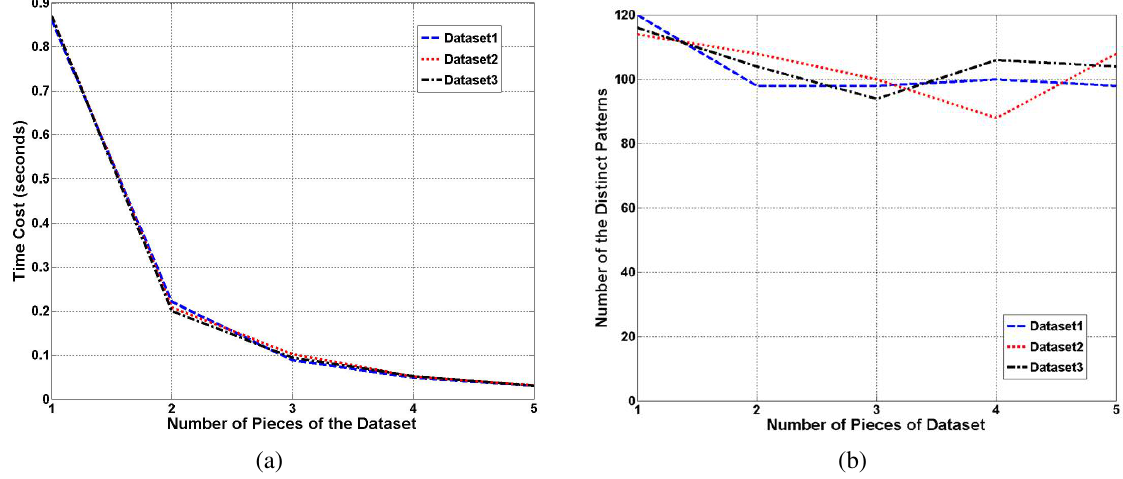
Figure 6: (a) Time cost for finding the distinct patterns when increasing the number of partitions, (b) Number of di ff erent patterns found when increasing the number of